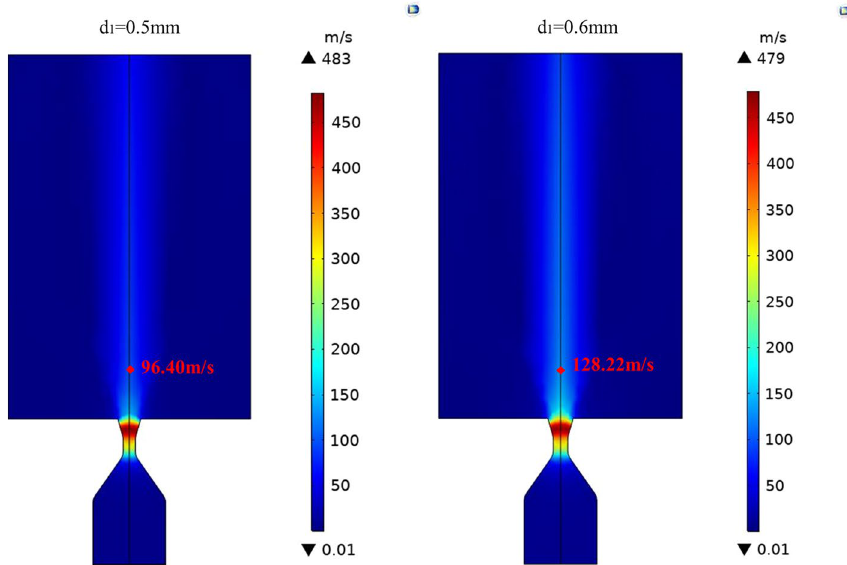
Figure 3. Simulation results of airflow velocity.